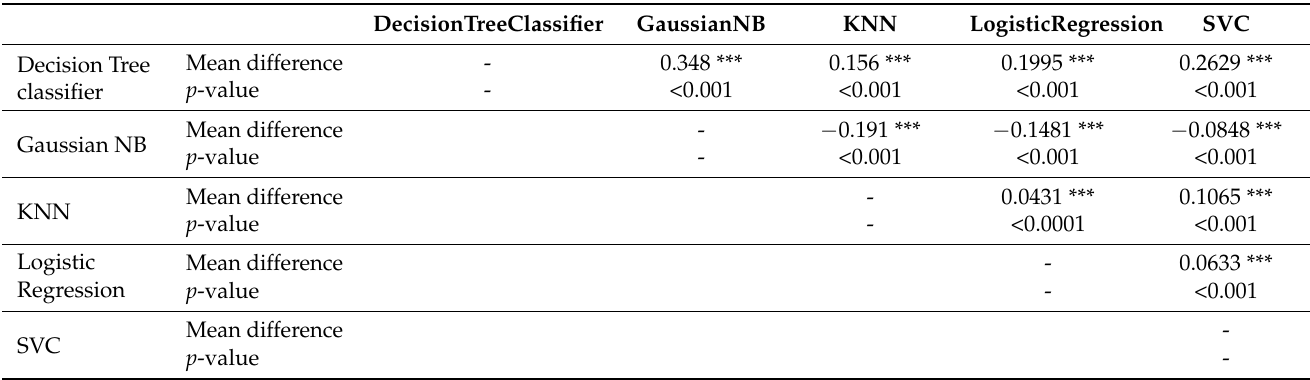
Table A6. The results of the Games–Howell pos hoc test on train AUC.